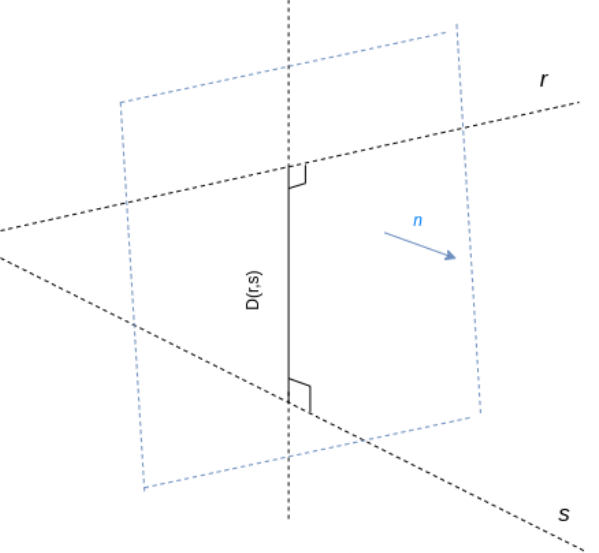
Figure 9. Line segment corresponding to the minimal distance between two